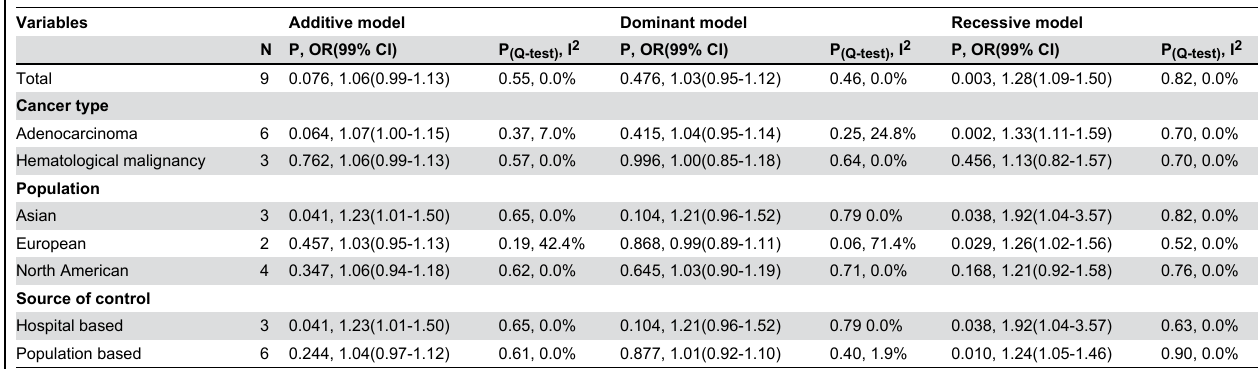
Table 5. Meta-analysis of rs2229094.